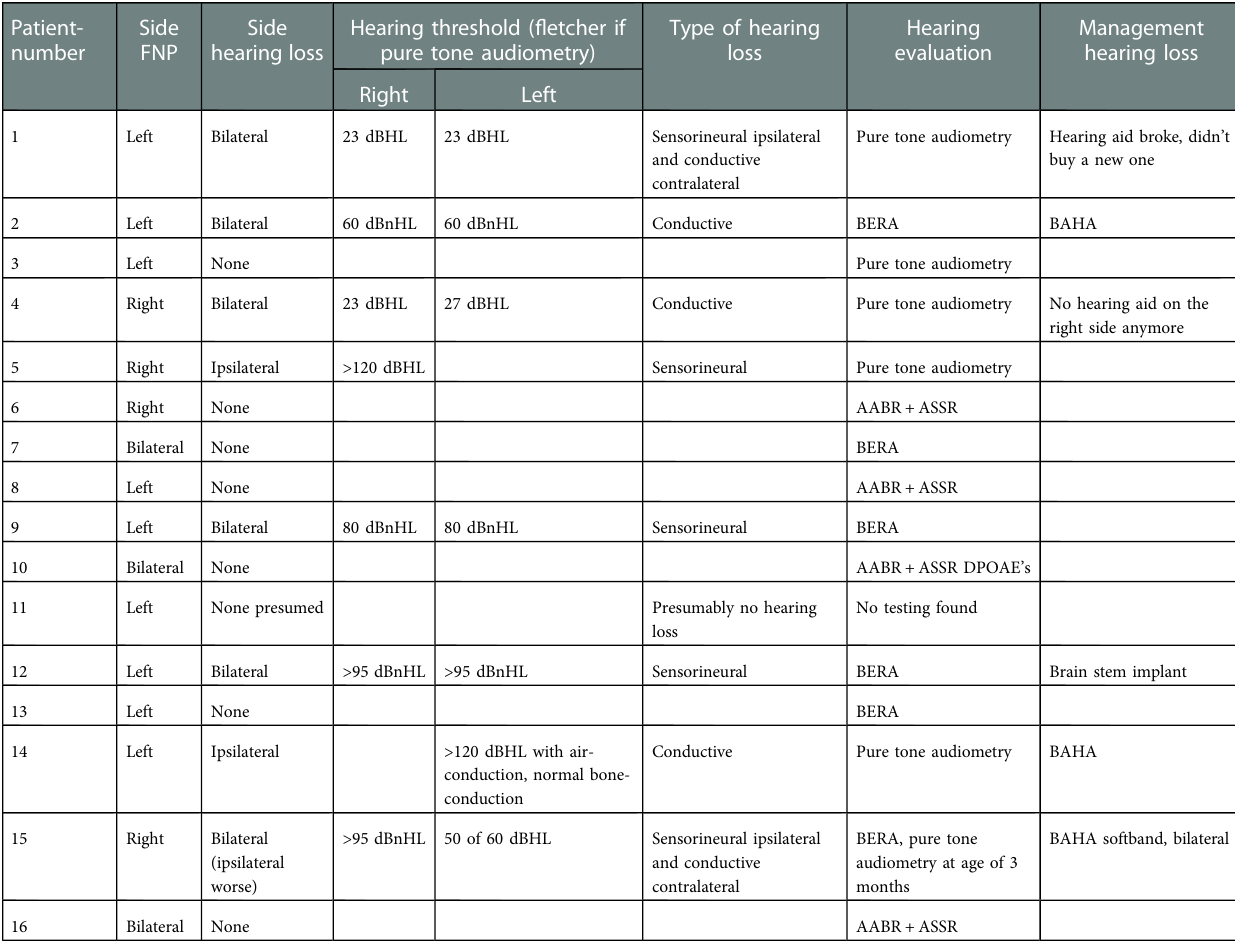
TABLE 3 Results hearing test. Patient-